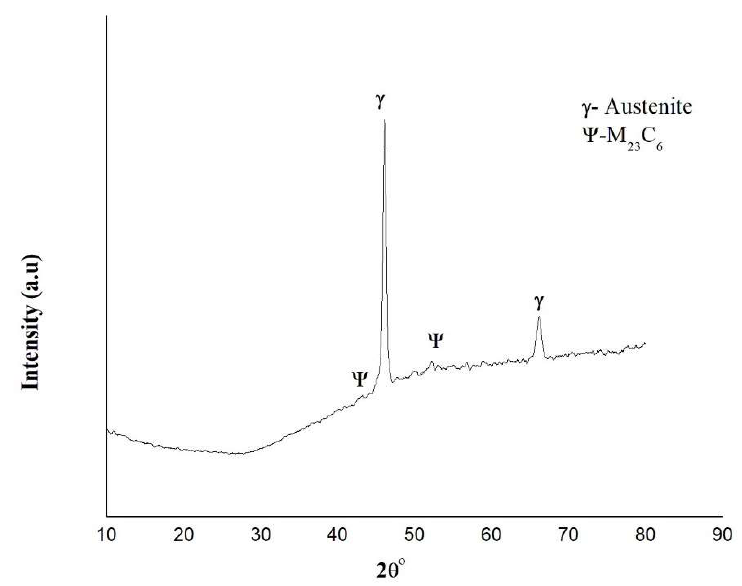
Figure 7. X-ray diffraction pattern for vacuum hot pressed sample.